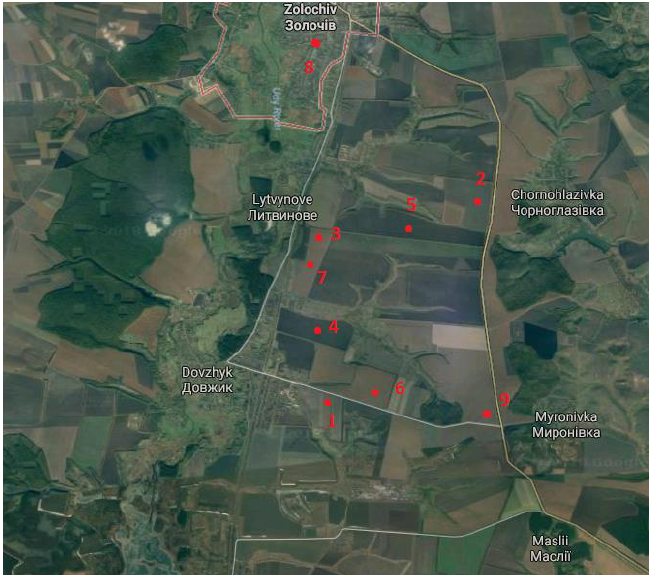
Fig. 1. Places of soil sampled in agricultural fields and fixed points: 1 – the field “barley,” 2 – the field “wheat,” 3 – the field “corn,” 4 – the field “buckwheat,” 5 – the field “sunflower,” 6 – the field “soybean,” 7 – the field “organic corn,” 8 – “vegetable garden,” 9 –